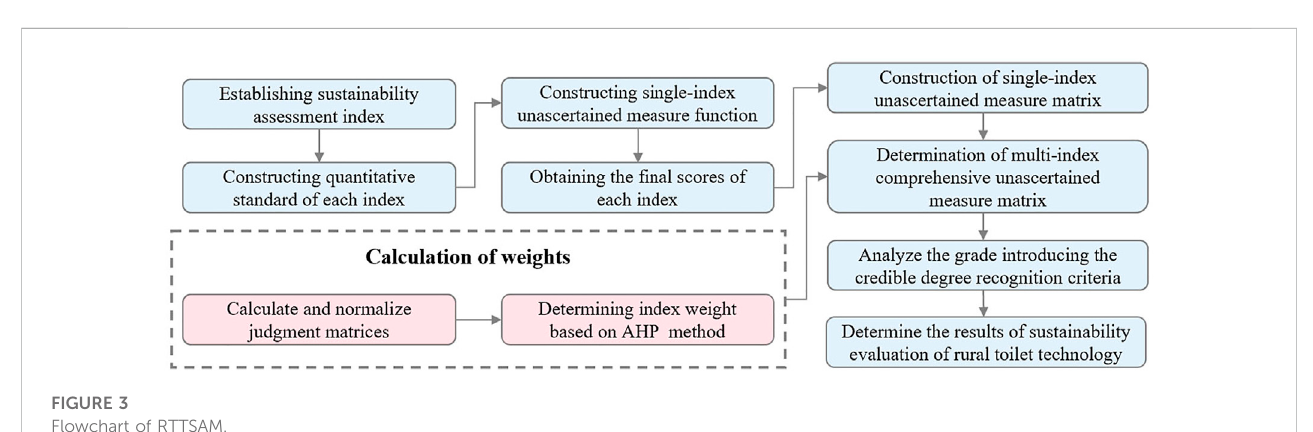
FIGURE 3 Flowchart of